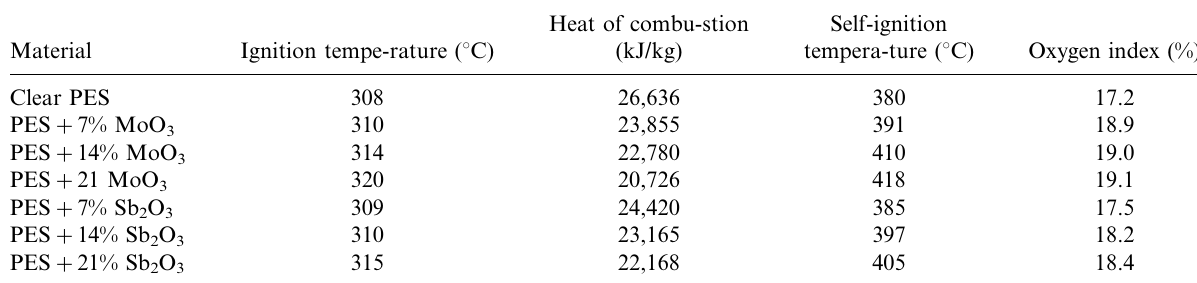
Table 2. Ignition temperature, heat of combustion, self-ignition and oxygen indexes of the studied polyester materials